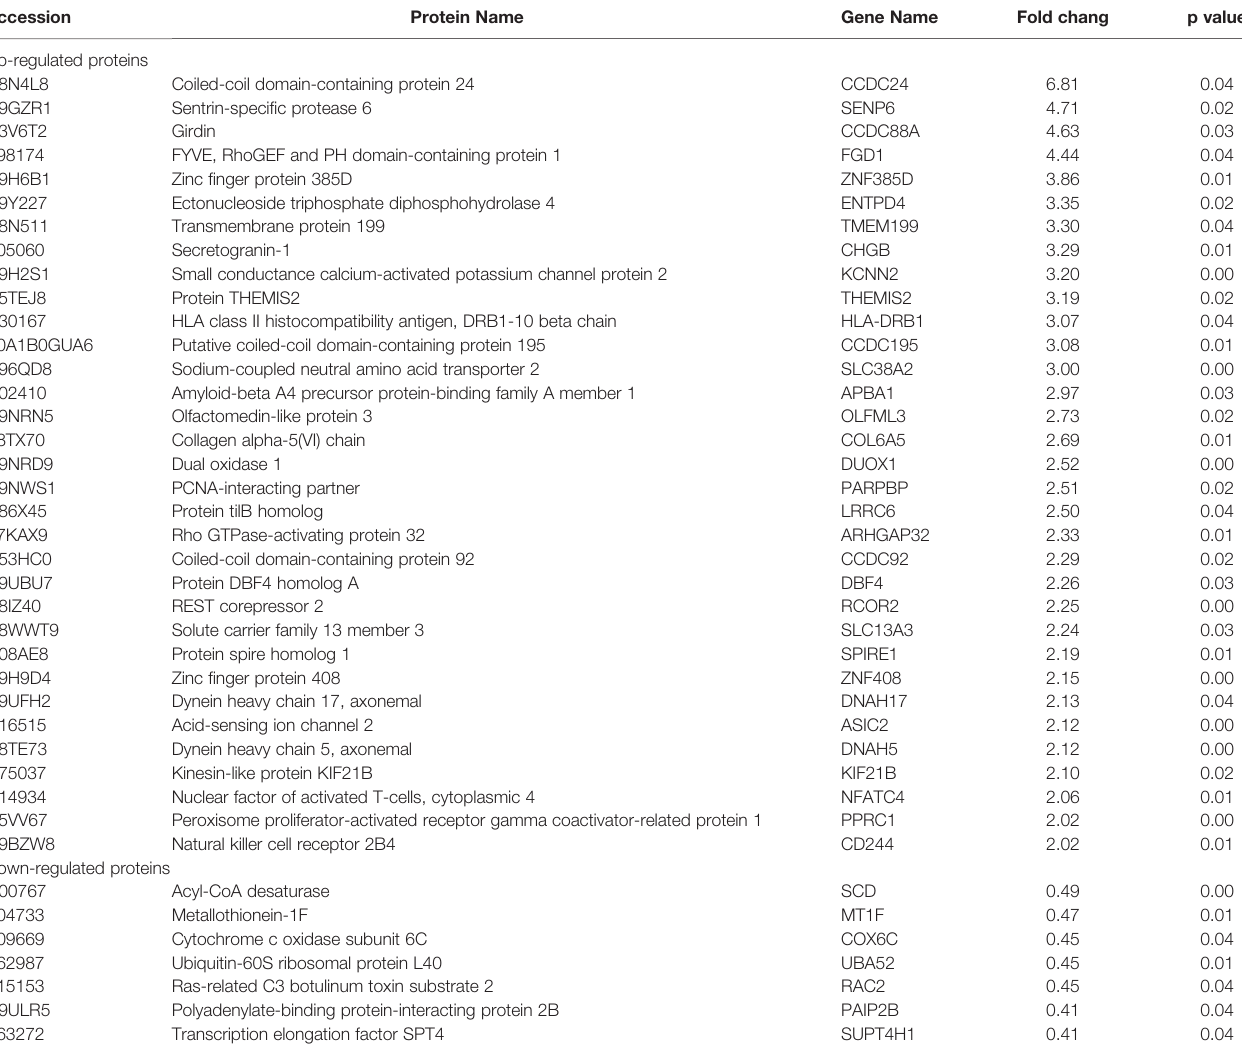
TABLE 1 | DEPs between PPM-treated groups and control groups in HCT 116